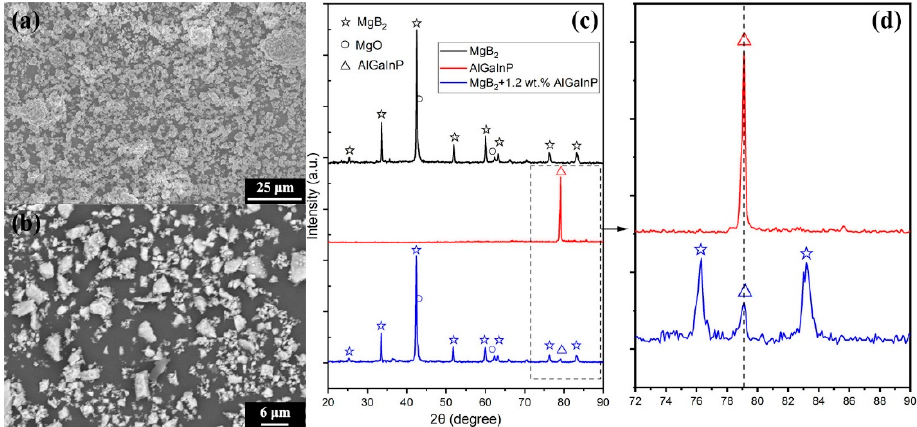
Figure 3. SEM diagram of ( a ) MgB 2 particles, diameter Φ ≤ 30 µm, ( b ) p-n junction particles, ground into 4 µm × 4 µm × 1.7 µm particles, ( c ) the XRD test curves of pure MgB 2 , AlGaInP and MgB 2 + 1.2 wt.% AlGaInP samples, ( d ) a partial enlarged drawing of ( c ). Table 1. MgB 2 doped inhoumgenous phase with different concentrations.